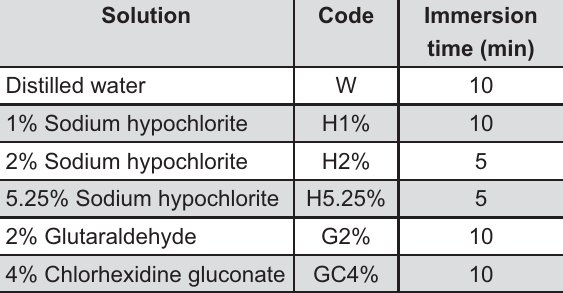
Figure 2- Chemical solutions tested in this